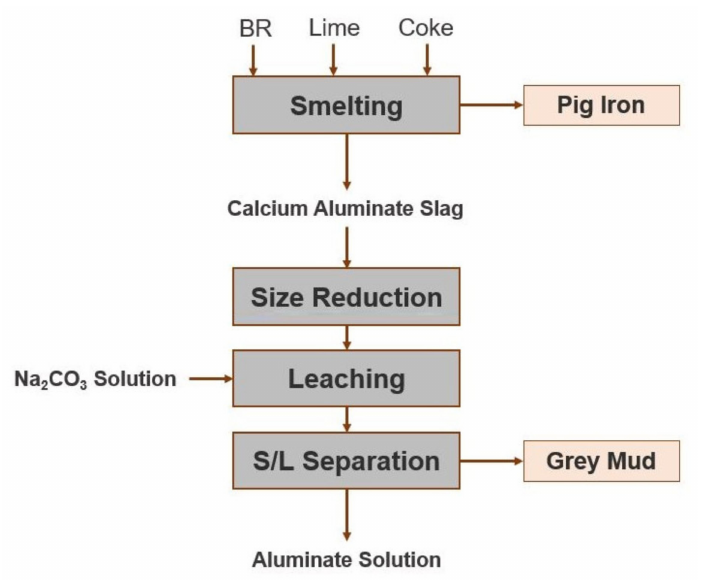
Figure 1. Conceptual flowsheet of the metallurgical process for the treatment of BR under investiga- tion in the present